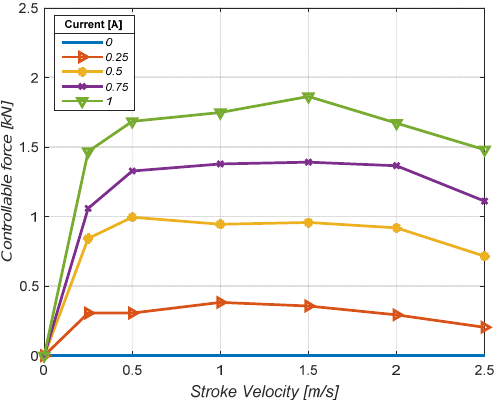
Figure 4. Stroke velocity vs. controllable force, according to applied current.